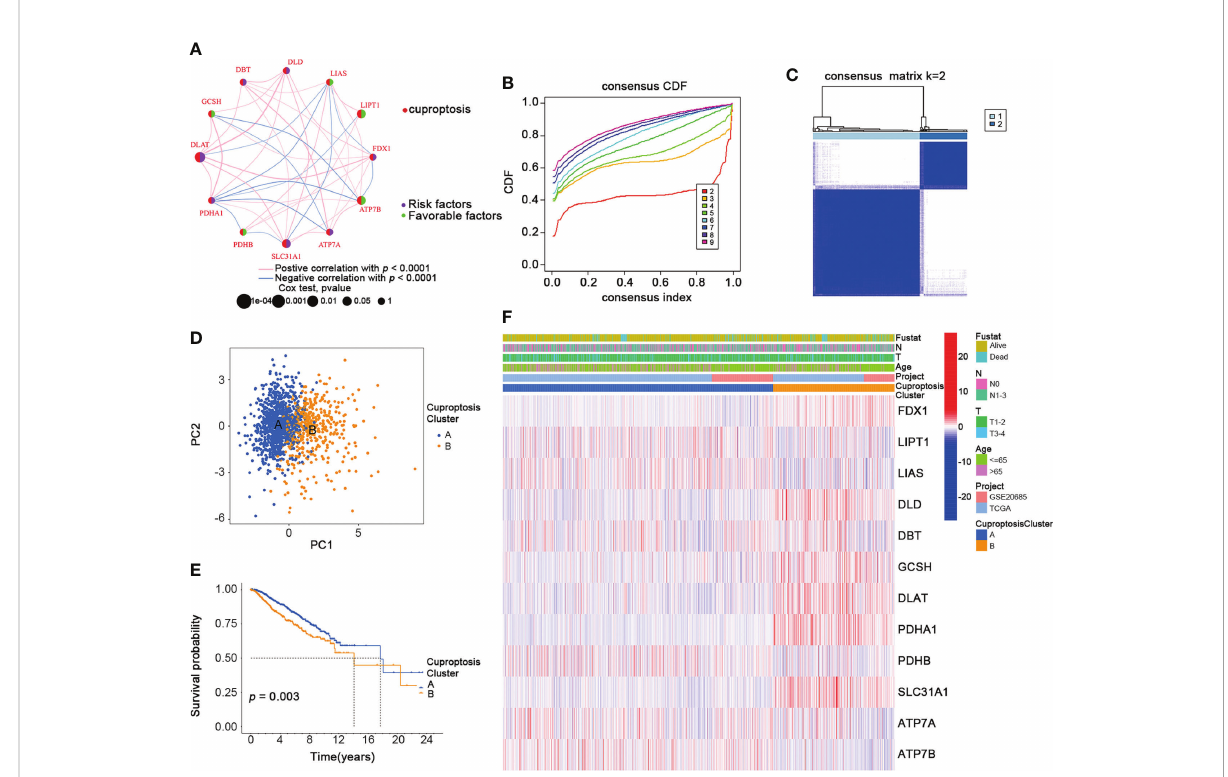
FIGURE 3 Identi fi cation of CuproptosisClusters in BRCA. (A) The interaction among CRGs in BRCA (green: favorable factors for overall survival; purple: risk factors for overall survival). (B) The relative change in area under consensus CDF curve for k=2 to 9. (C) The consensus clustering of BRCA patients for k = 2. (D) The PCA analysis of the two CuproptosisClusters. (E) The OS of the two CuproptosisClusters (Log-rank test). (F) The heatmap for the connections between clinicopathologic features and the two CuproptosisClusters (blue: low expression; red: high expression). CDF, cumulative distribution function; PCA, Principal component analysis; OS, overall survival. * p < 0.05, ** p < 0.01, *** p <